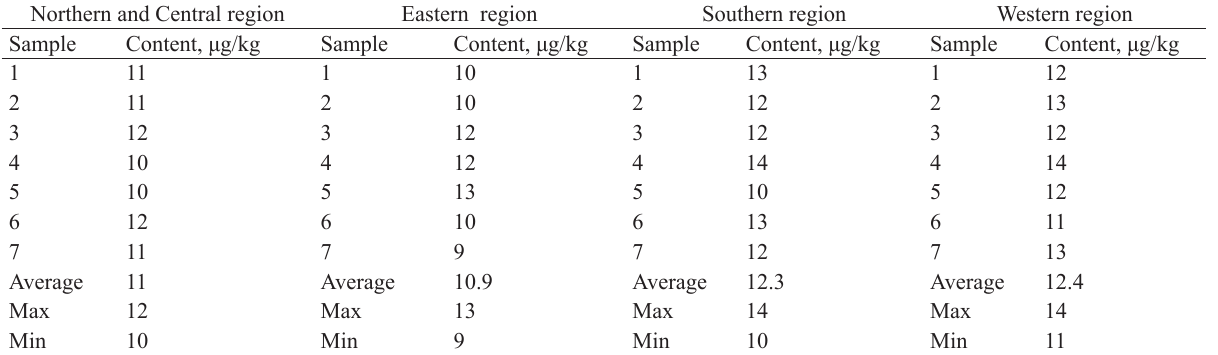
Table 3 Arsenic contents in raw milk samples Northern and Central region